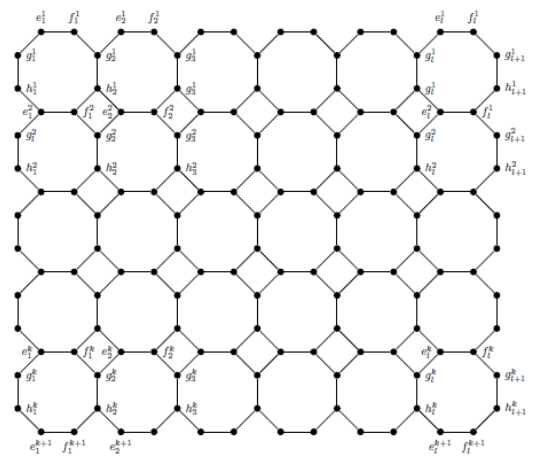
Figure 1. Octagonal planar